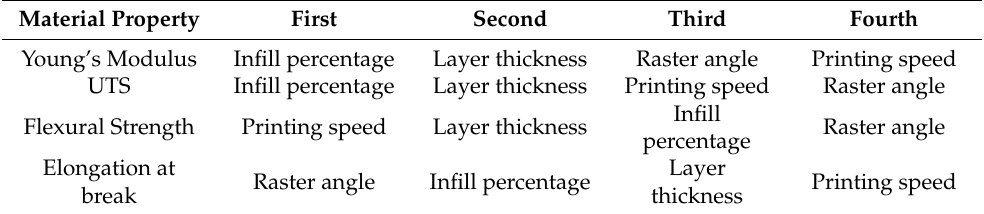
Figure 21. Process parameter’s relative influence on PETG mechanical properties. Table 9. Table ranking parameters according to influence on PETG mechanical properties as deter- mined by